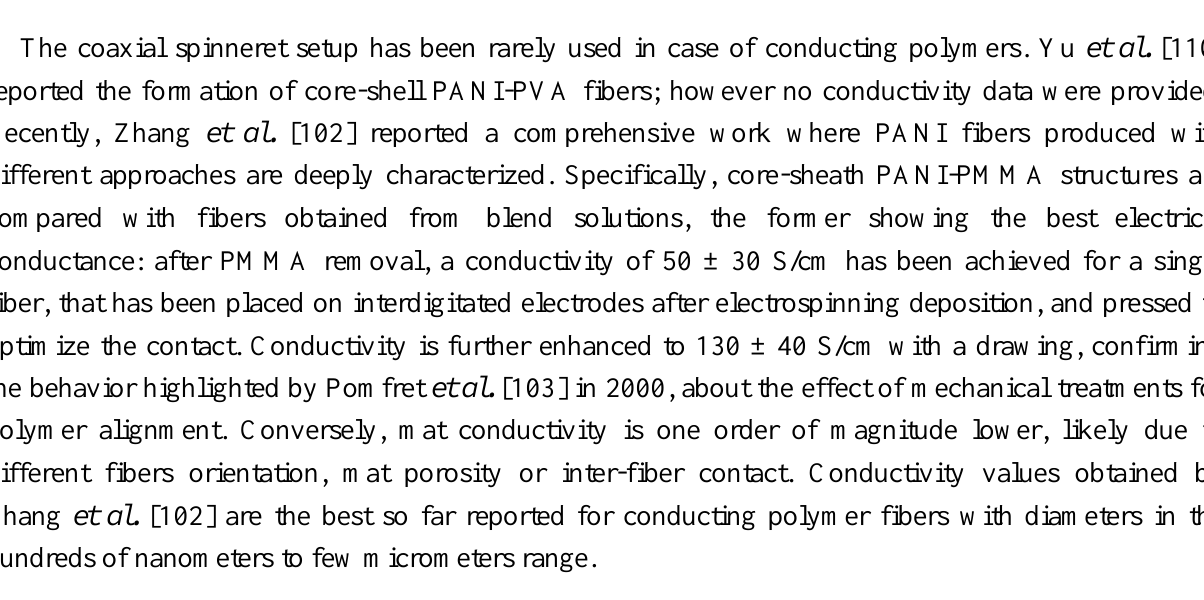
Table 1. Survey of conductivities achieved so far in polymer